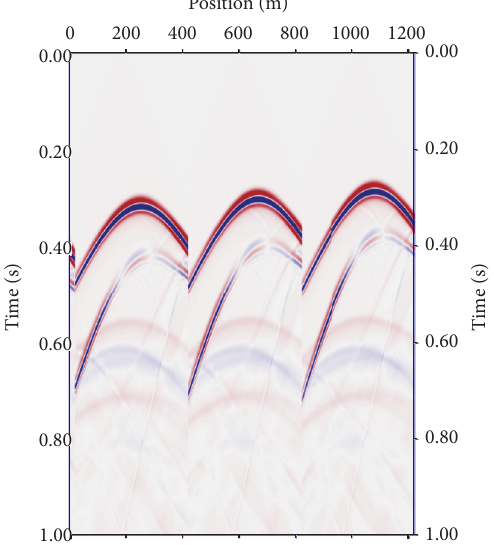
Figure 10: The synthetic traces from the inclined-interface